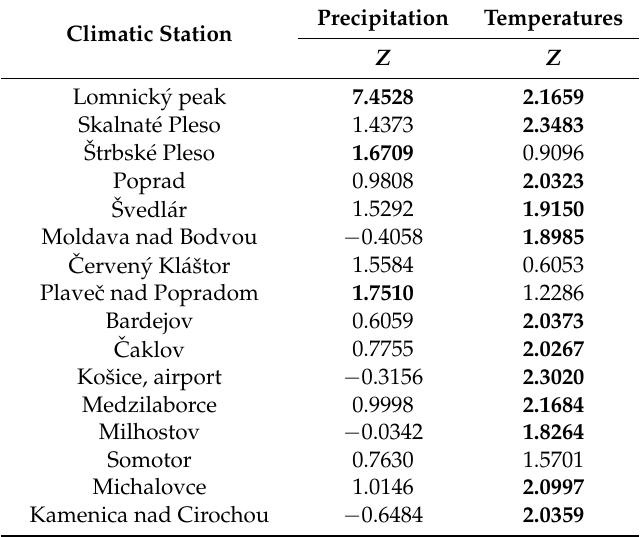
Table 6. Values of Z statistics of the MK test at 95% confidence level.